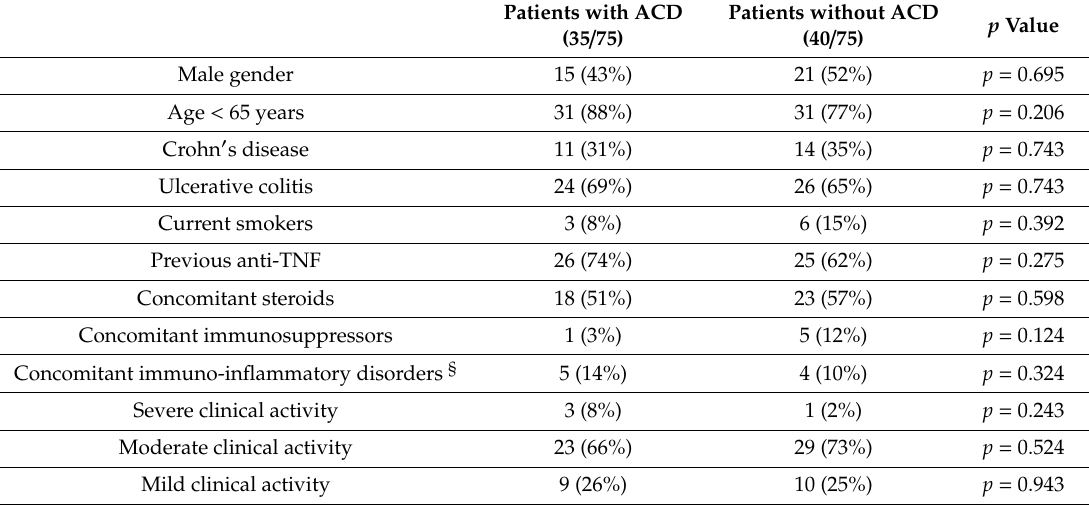
Table 1. Distribution of baseline demographic / clinical characteristics and clinical response to Vedolizumab in patients with ACD and those without